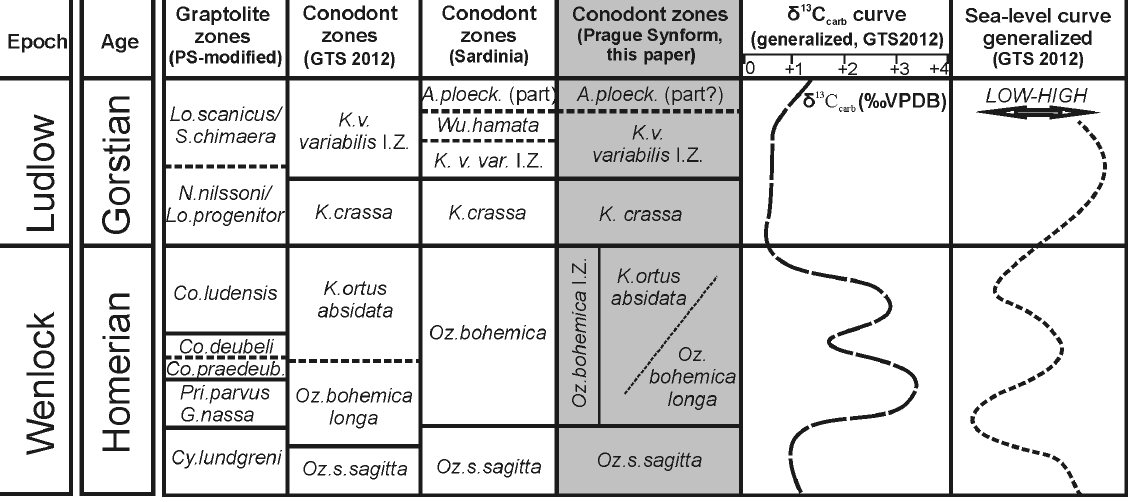
Fig. 1. A correlation chart for the Homerian(cid:150)Gorstian interval. Graptolite zonation for the Prague Synform is modified according to (cid:138)torch et al. (2014) and juxtaposed with conodont zonal scales: (1) standardized (cid:150) Geological Time Scale, The Silurian Period (Melchin et al. 2012) ((cid:145)GTS 2012(cid:146)); (2) Sardinian zonation (Corradini & Serpagli 1999); (3) zonation for the Prague Synform (this paper). The zonations are matched against the generalized carbon isotope and eustatic curves (cid:150) Geological Time Scale, The Silurian Period (Melchin et al. 2012) ((cid:145)GTS